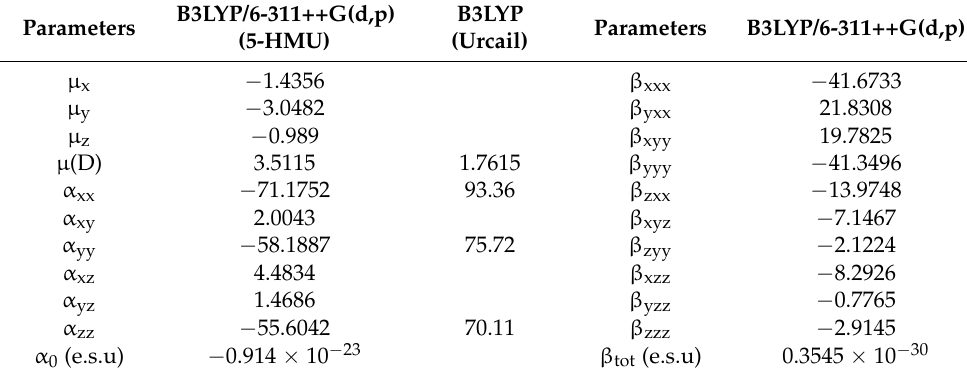
Table 4. The calculated dipole moment µ (D), polarizability ( α 0 ), and first-order hyperpolarizability ( β tot ) components of Table 4 . The calculated dipole moment μ(D), polarizability (α0), and first-order hyperpolarizabil- ity (β tot ) components of 5-HMU.